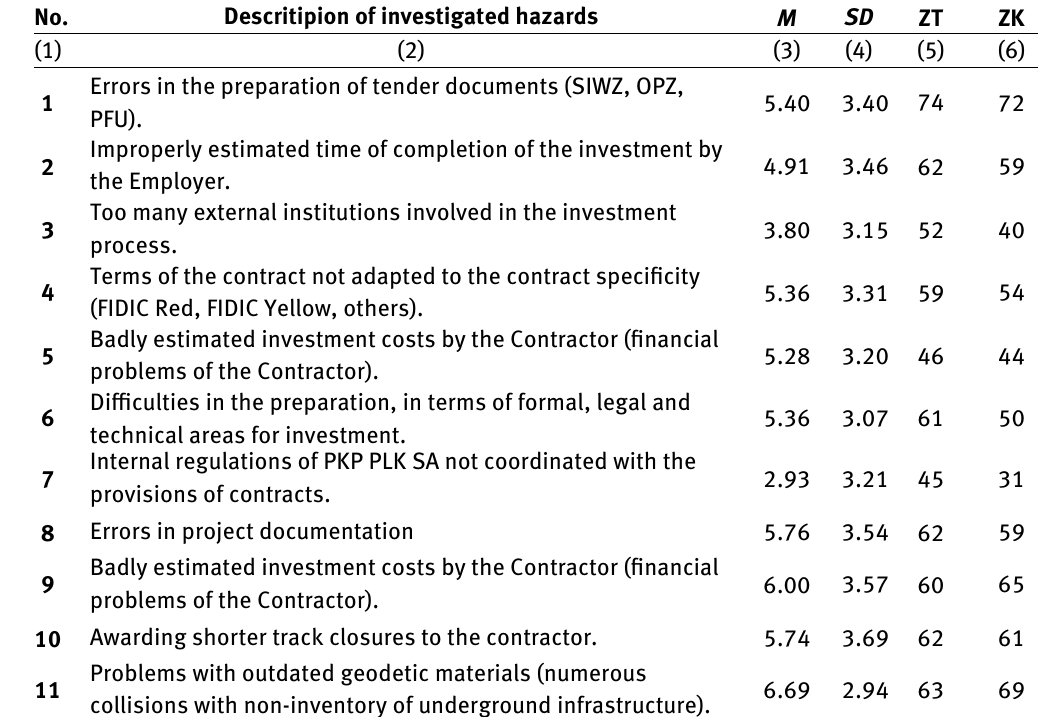
Table 2: Identified hazards – build stage. No. Descritipion of investigated